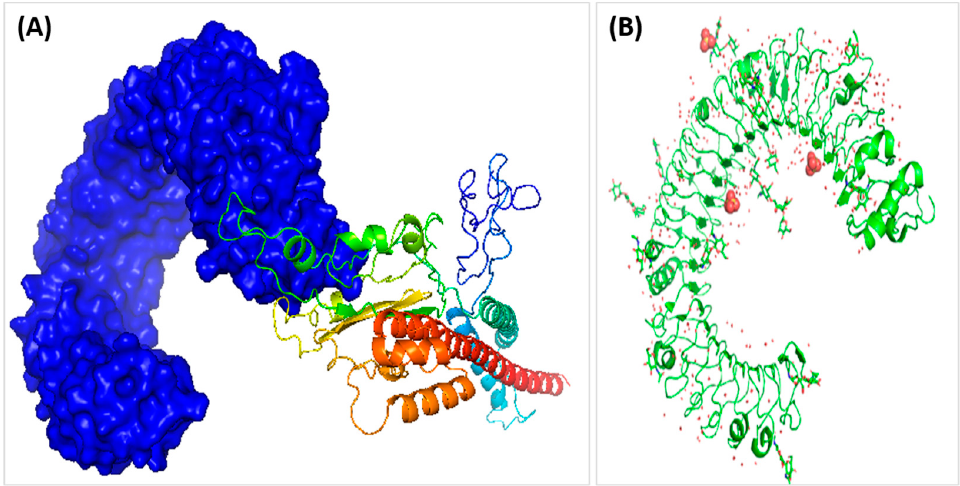
Figure 4. ( A ) 3D docked structure of vaccine constructs and TLR-3 using Cluspro 2.0 in which the construct acts as receptor and TLR_3 as the legend for the formation of docked complex. ( B ) 2A0Z is used as the legend for docking with vaccine construct.